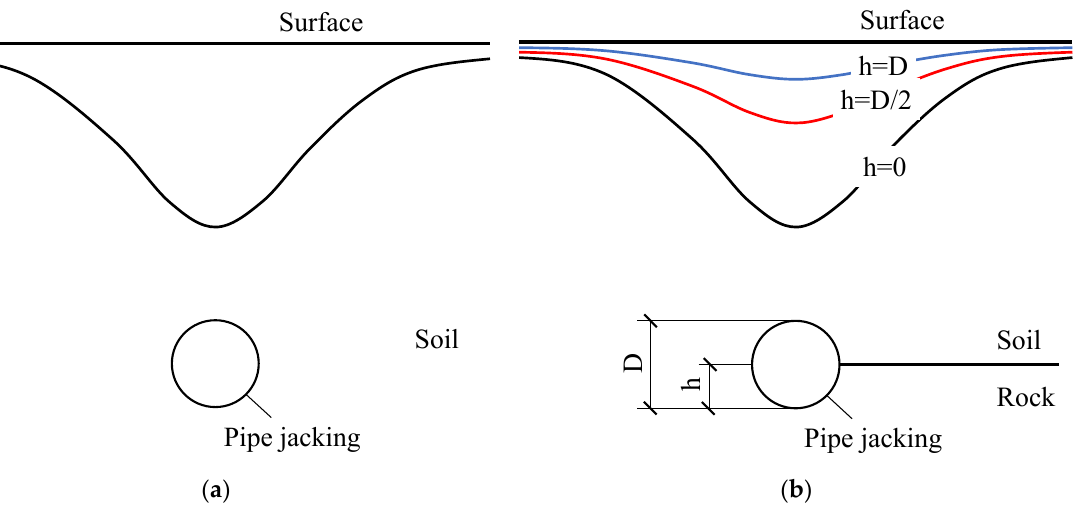
Figure 13. Ground settlement. ( a ) Surface settlement curve of pipe jacking construction in the soil layer; ( b ) surface settlement curve of pipe jacking construction in soil–rock composite strata.